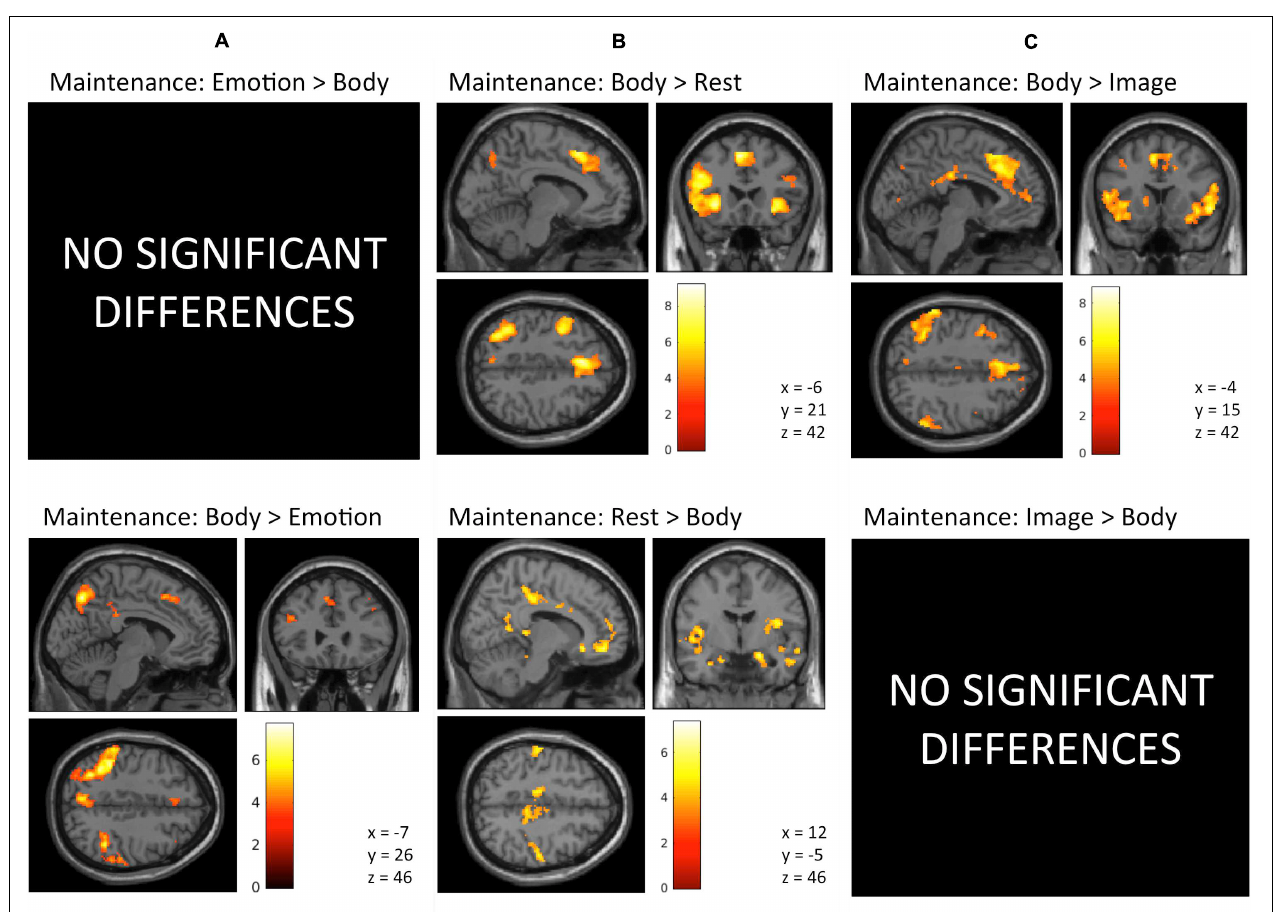
FIGURE 3 | Illustration of the imaging results contrasting the maintenance period of the (A) Emotion and Body conditions, (B) Body and Rest conditions, and (C) the Body and Image conditions reported in Tables 1 – 3 . As in the tables, the clusters displayed here are thresholded based on a cluster-forming height threshold of p < 0.001 (uncorrected), and a subsequent cluster extent threshold of p < 0.05 (FDR-corrected). Images are shown in neurological orientation (i.e., left = left; right = right). For the results of contrasts of the Emotion, Image, and Rest conditions, see our previous report (Smith et al.,